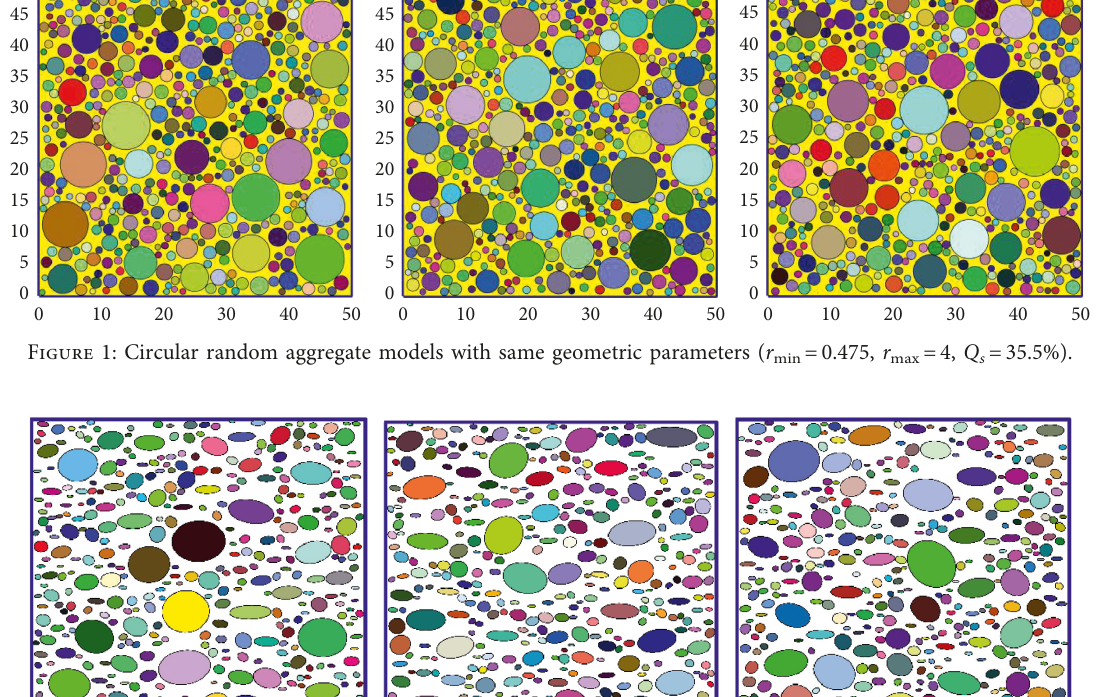
� 0.475, r � 4, Q � min max s